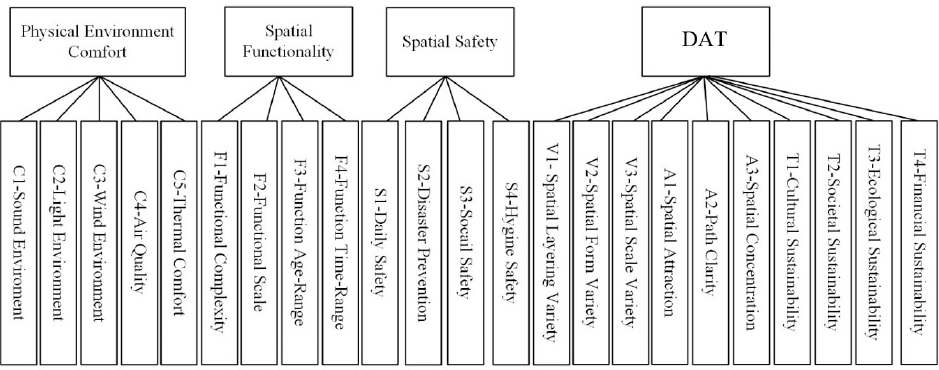
Figure 2. Adjusted value composition of outdoor space.